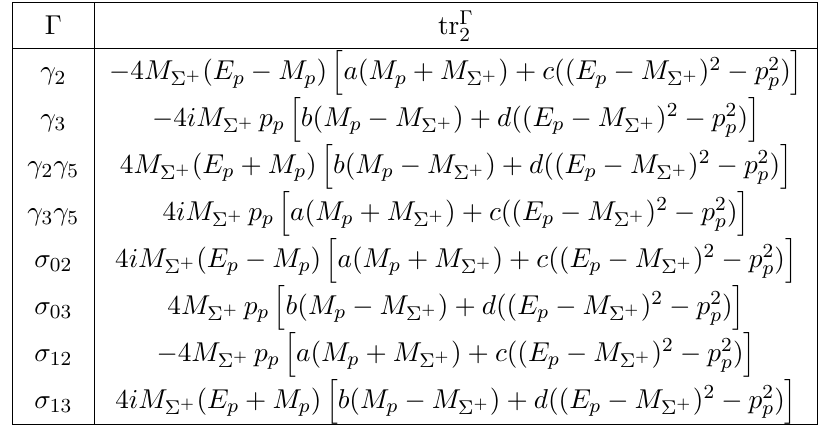
Table 2 . Traces for µ = 2 and ~k = 0 , ~p = ( p p , 0 , 0) . All traces that are not explicitly given are 0